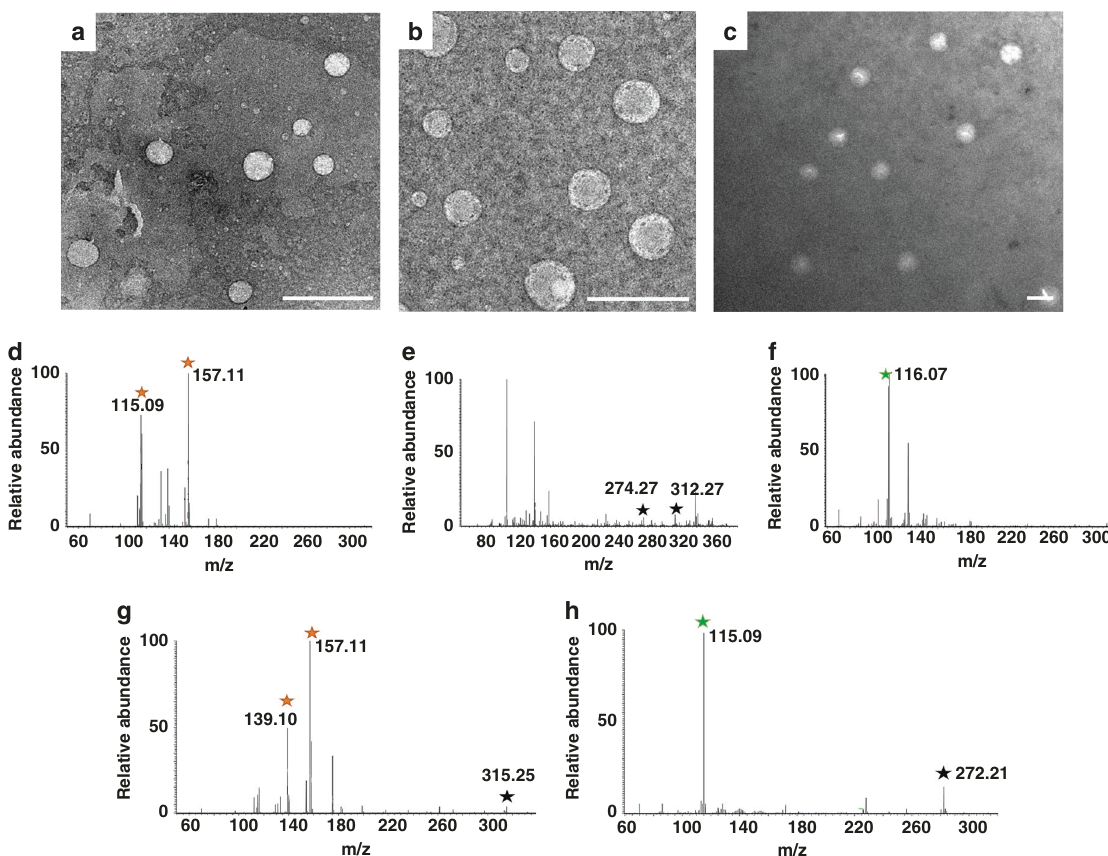
Fig. 2 Characterizations of the nanomotors. TEM images of a HLA 5 , b HLA 10 , and c HLA 15 negatively stained with uranyl acetate (scale bar: 500 nm); MS spectra of d L -arginine, e HPAM, f L -citrulline, g HLA 10 nanomotor, and h HLC (supernatant HPAM/L-citrulline composite after HLA 10 nanomotor reacting with 10% H 2 O 2 for 24